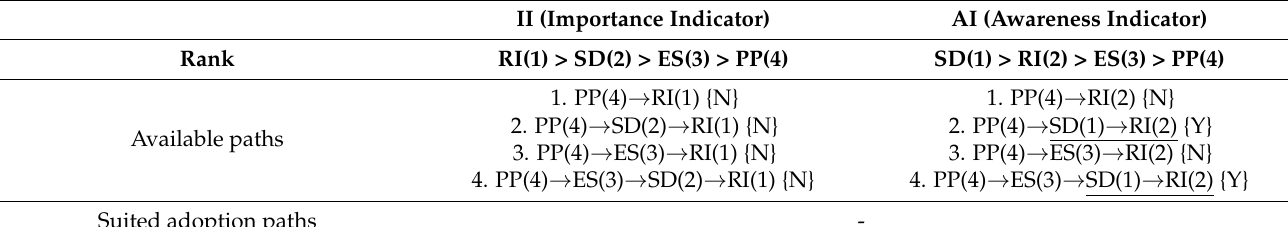
Table 11. The suited adoption paths of competency development for PGYs.